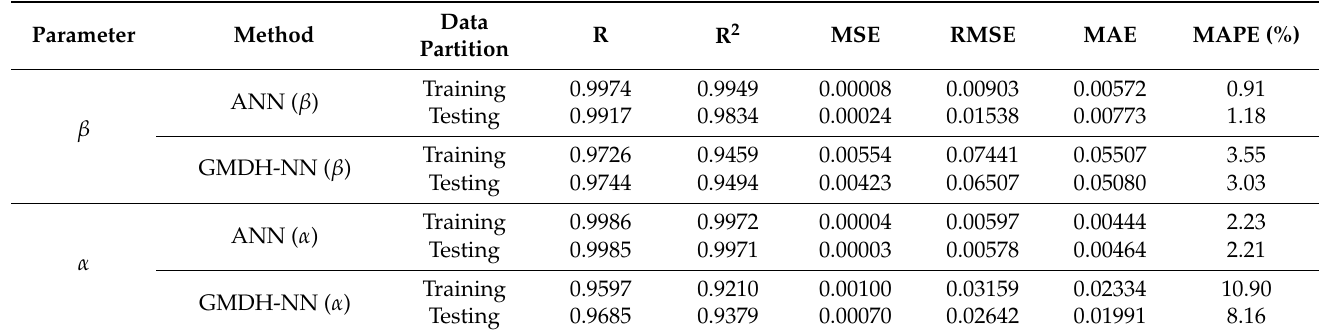
Table 6. The errors and performances of ANN and GMDH-NN